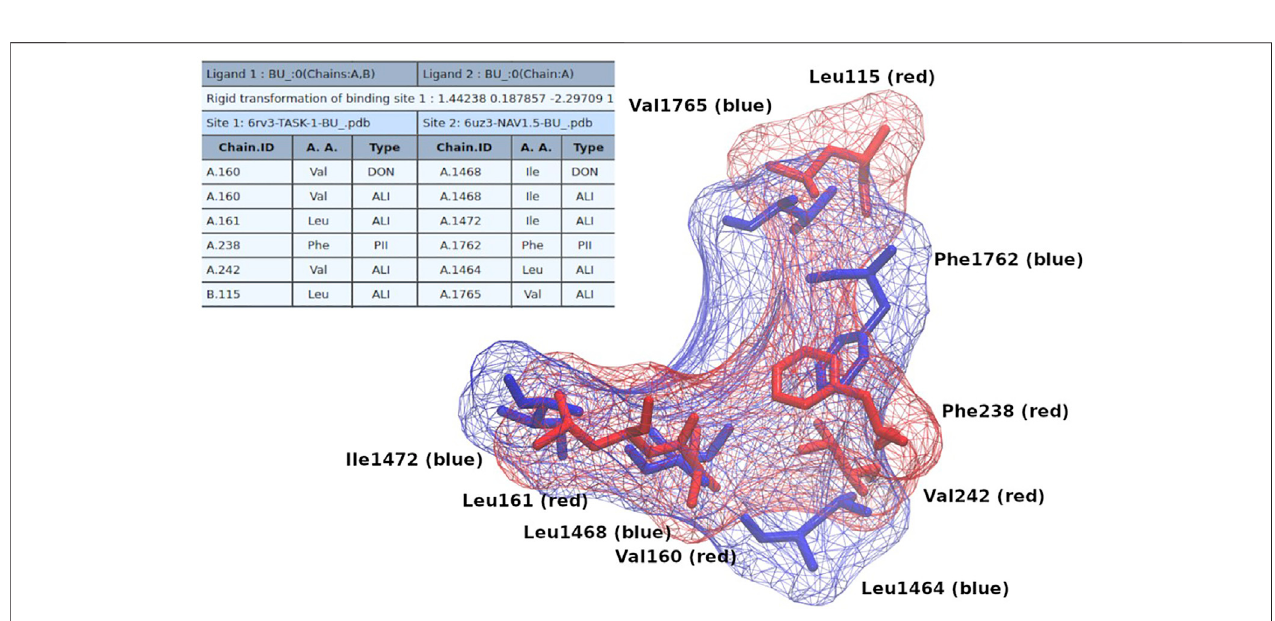
FIGURE7| CommonbindingsiteofbupivacaineonTASK-1andNaV1.5. Thetable(fromMultibind) indicatestheequivalent physicochemicalpropertiesmatched. The colored residues depicted in licorice show the alignment (from PocketAlign) of the bupivacaine binding sites on both proteins (Red: NaV1.5; Blue: TASK-1).